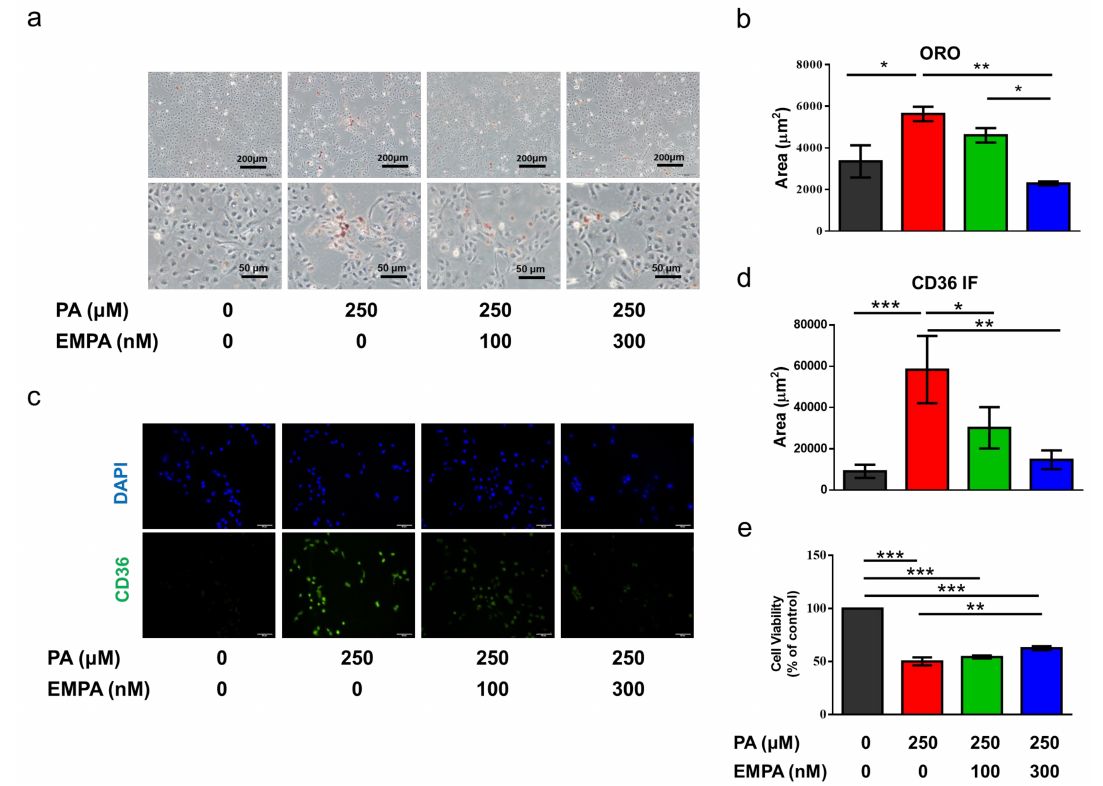
Figure 4. Empagliflozin ameliorates PA-induced lipid deposition, CD36 expression, and cell death in a proximal tubular cell line (HK-2). ( a , b ) Based on Oil red O-stained images, empagliflozin prevents lipid deposition in PA-treated HK-2 cells in a dose-dependent manner (scale bars at upper panel = 200 µ m, lower pane l= 50 µ m). ( c ) Immunofluorescent staining shows the upregulation of membranous CD36 (green) in the PA-treated group, while empagliflozin attenuates its expression. Scale bar = 50 µ m ( d ) Quantitative results for immunofluorescent intensity are shown as mean ± standard error (SE) from 6 experiments. ( e ) Based on the cell viability test ( n = 6), high-dose empagliflozin ameliorates PA-induced cell death. The histograms represent mean ± SE; Statistical analysis was performed with one-way ANOVA. * p < 0.05, ** p < 0.01, *** p < 0.001. Original magnification: 200 × . EMPA, empagliflozin, PA, palmitic